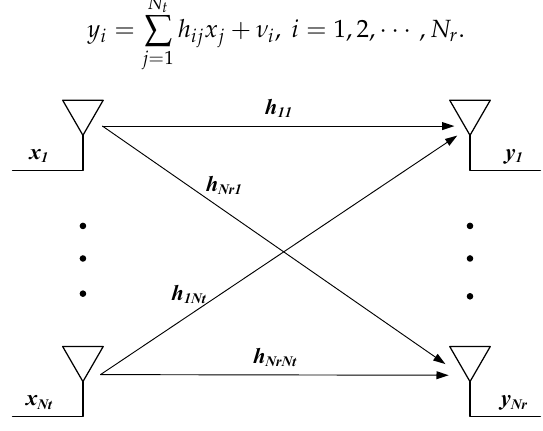
Figure 1. Multiple-input multiple-output (MIMO) channel.